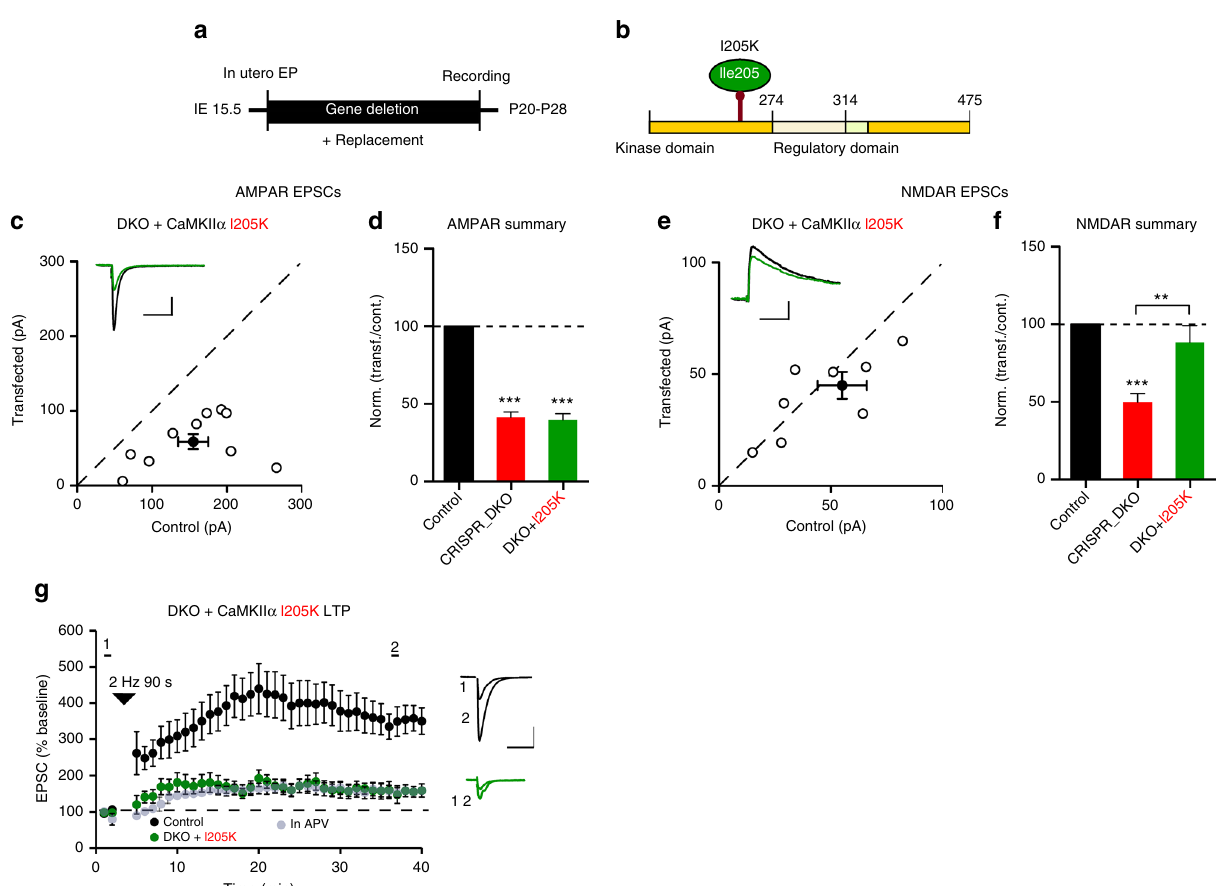
Fig. 8 CaMKII α binding to GluN2B is critical for LTP. a Timeline of the experiment. b Scheme of the structural organization of CaMKII α showing the point mutation (I205K light green). c Scatterplot showing amplitudes of AMPAR EPSCs for single pairs (open circles) of control and transfected cells of DKO + CaMKII α I205K ( c , n = 10 pairs). Filled circle indicates mean ± SEM ( c , Control = 155.2 ± 20.7; DKO + CaMKII α I205K = 59.8 ± 10.8, p < 0.0001). d Bar graph of ratios normalized to control (%) summarizing the mean ± SEM of AMPAR EPSCs of values represented in c (39.9 ± 6.1, p = 0.0007). DKO data (red bar) from Fig. 2f are included in the graph. e Scatterplot showing amplitudes of NMDAR EPSCs for single pairs (open circles) of control and transfected cells of DKO + CaMKII α I205K ( d , n = 9 pairs). Filled circle indicates mean ± SEM ( e , Control = 55.3 ± 11.7; DKO + CaMKII α I205K = 43.4 ± 6.2, p = 0.17). f Bar graph of ratios normalized to control (%) summarizing the mean ± SEM of NMDAR EPSCs of values represented in e (90.3 ± 11.2, p = 0.38). DKO data (red bar) from Fig. 6e are included in the graph. g Plots showing mean ± SEM AMPAR EPSC amplitude of control (black) and transfected (green) CRISPR_DKO + CaMKII α I205K pyramidal neurons normalized to the mean AMPAR EPSC amplitude before LTP induction (arrow) (Control, n = 12; DKO + CaMKII α I205K, n = 9, p = 0.0049 at 35 min). Sample AMPAR EPSC current traces from control (black) and electroporated neurons (green) before and after LTP are shown to the right of each graph. Gray plots represent mean ± SEM AMPAR EPSC amplitude of LTP induction in APV 50 μ M. Raw amplitude data from dual cell recordings were analyzed using Wilcoxon signed rank test ( p values indicated above). Normalized data were analyzed using a one-way ANOVA followed by the Mann − Whitney test (*** p < 0.0001; ** p < 0.001). Mann − Whitney test was used to compare LTP at 35 min ( p values indicated above). Scale bars: 50 ms, 50